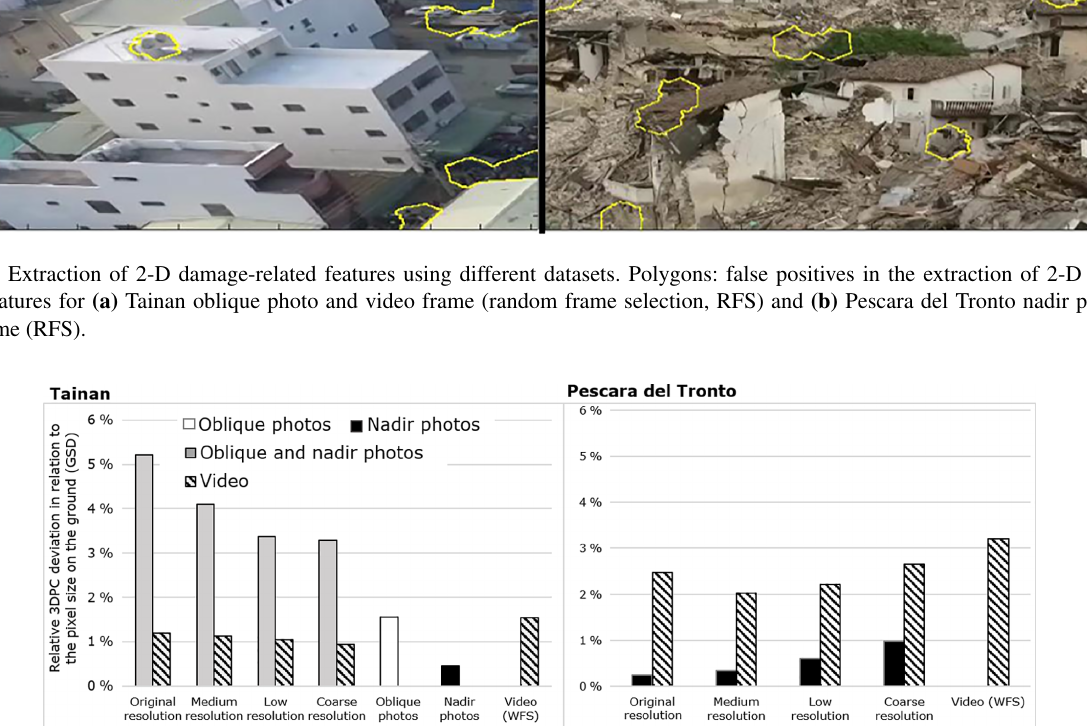
ability), but the accuracy was still the same as RFS-video- based